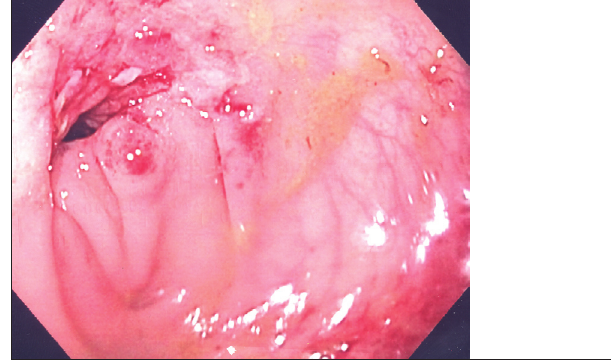
Figure 1) Endoscopic image. Stricture at 40 cm from the anal verge apparent on colonoscopy before chemotherapy